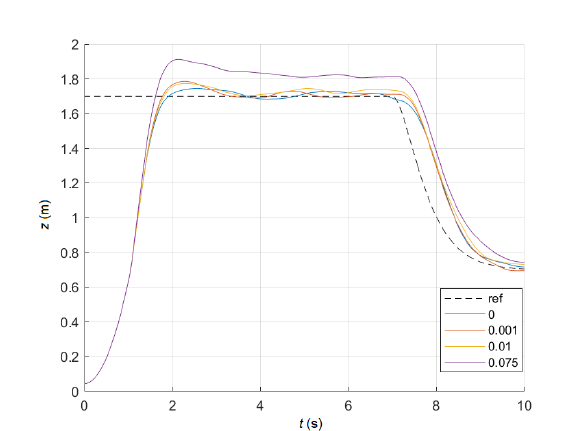
Figure 9. Performance of the altitude stabilization for various integral gains of the PID